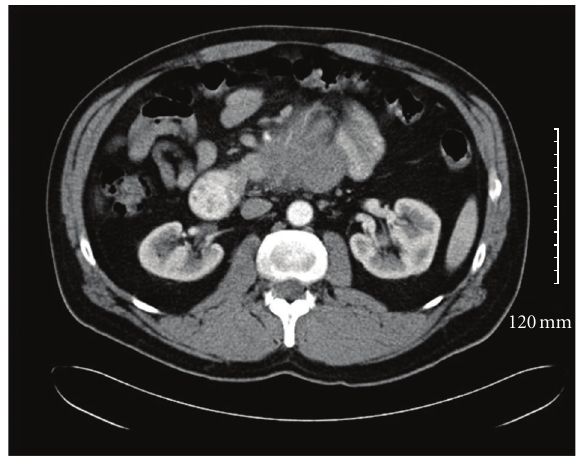
Figure 1: Initial CT abdomen with contrast showing a di ff use 6.1cm × 5.9cm × 8cm thickening of the wall of duodenum with adjacent encasement of the superior mesenteric